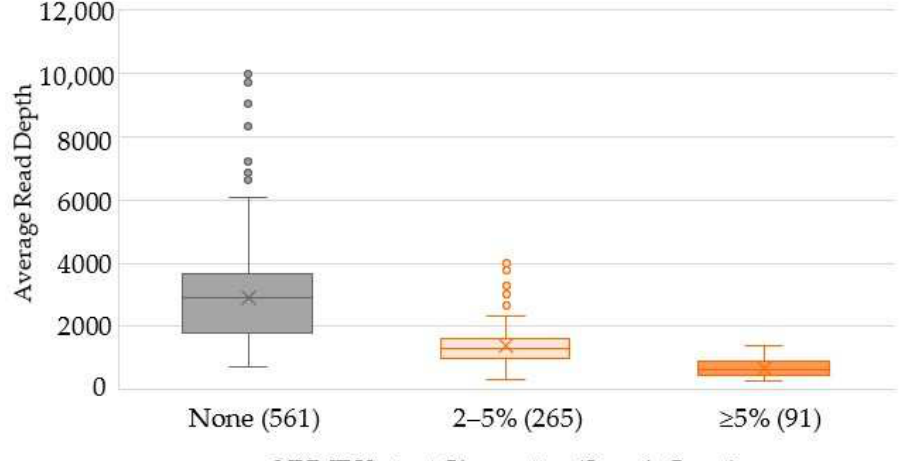
Figure 4. Distribution of the frequency (>5%) of the minor nucleotide for the 420 PHPs (green) in- cluded in the SweGen haplotypes and the 413 NUMT variants (orange) identified in the mitoge- nomes. The average for each classification is shown as an “×” and outliers are shown as single data points.